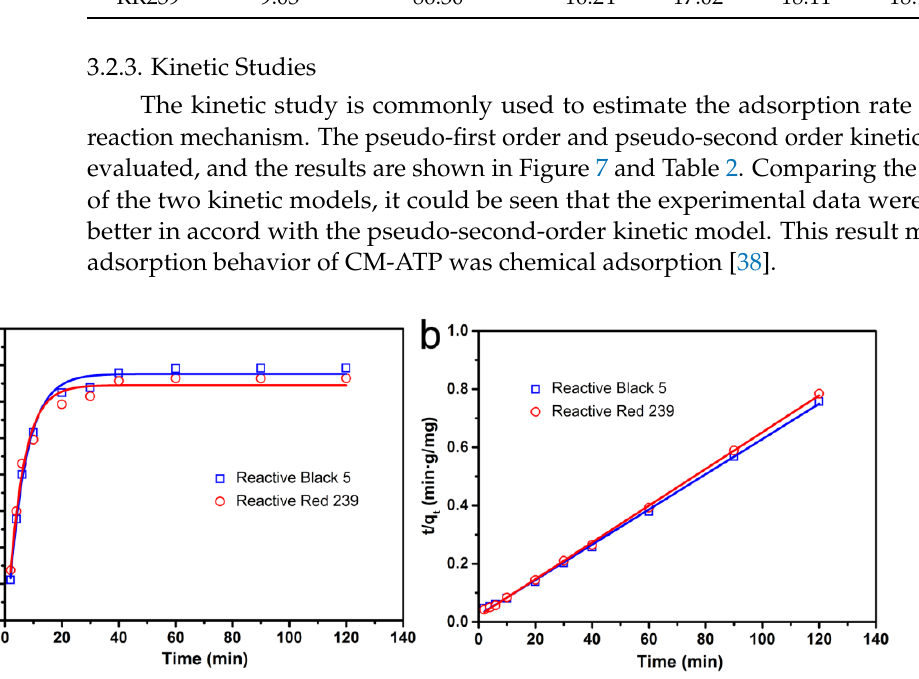
Figure 7. Kinetic adsorption fitting curves for dyes on CM-ATP. ( a ) pseudo-first-order kinetic model, ( b ) pseudo-second-order kinetic model.